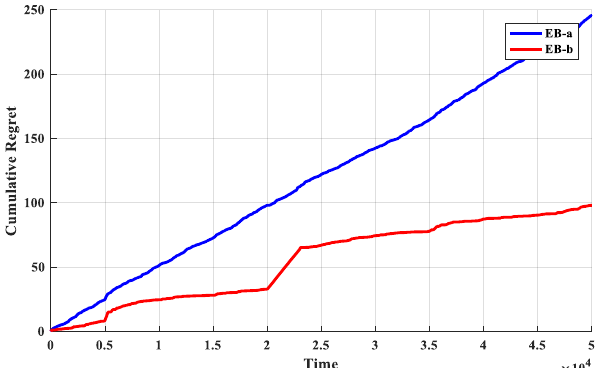
Figure 7. The cumulative regret of different policies for different scenarios.